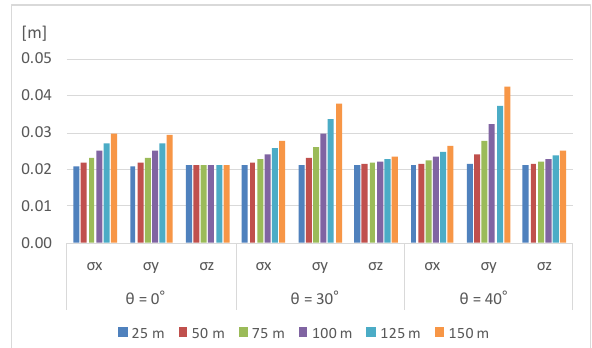
Figure 7. Differences in the three-dimensional reconstruction